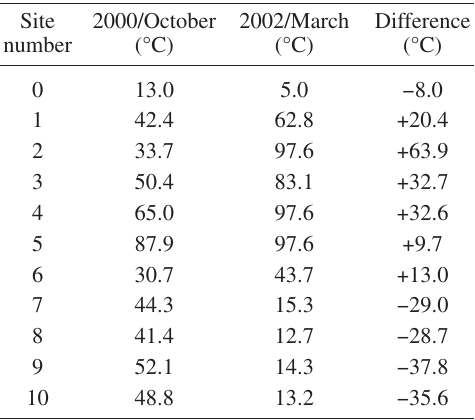
Table I. Temporal variation of ground temperature. Site numbers correspond with those shown in fig. 4.